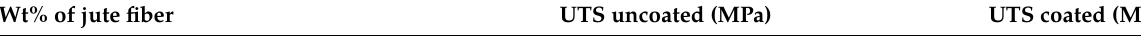
Table 6: Comparison of UTS for uncoated and coated